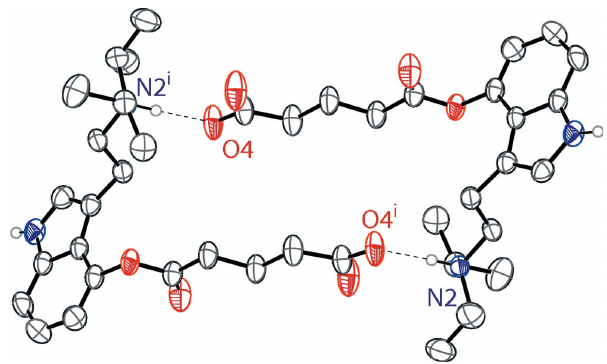
Figure 2 The ring formed by the dimerization of two zwitterionic 4-glutarato- N , N - diisopropyltryptamine molecules with graph set notation of R 2 image shown is from the methanol solvate. Hydrogen bonds are shown as dashed lines. H atoms not involved in hydrogen bonding are omitted for clarity. Symmetry code: (i) 1 (cid:4) x , 1 (cid:4) y , 1 (cid:4) z .